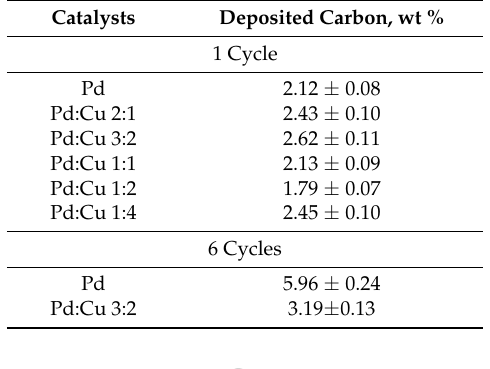
Table 3. Deposited carbon on spent catalysts performed reaction tests of one and six cycles.